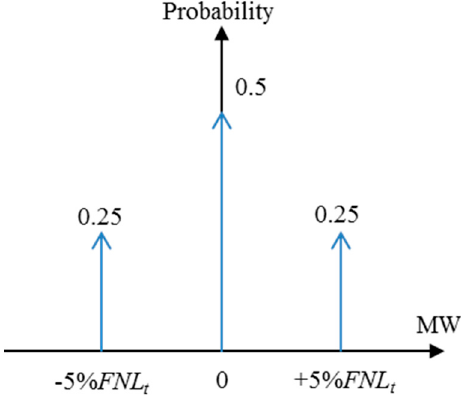
Figure 1. Triangular distribution for the example.